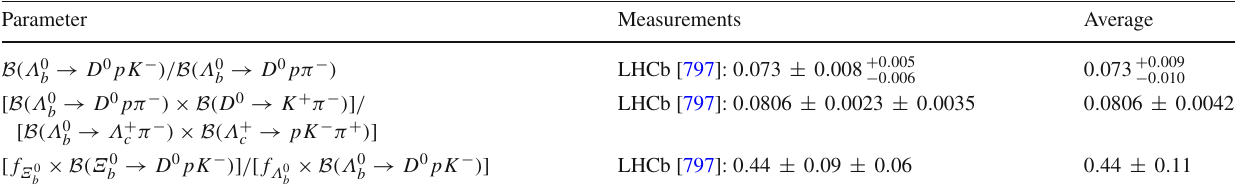
Table 207 Relative decay rates to D 0